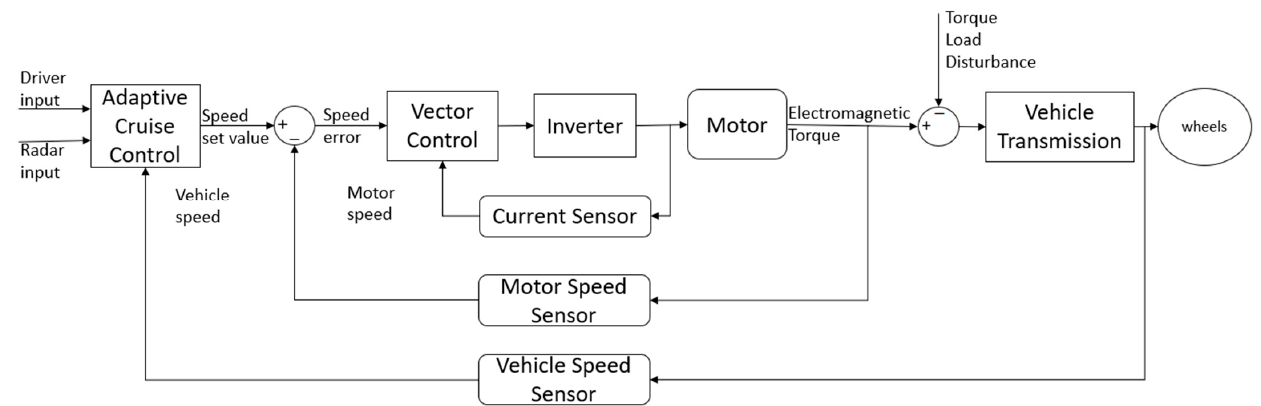
Figure 7. EV control system with adaptive cruise control.